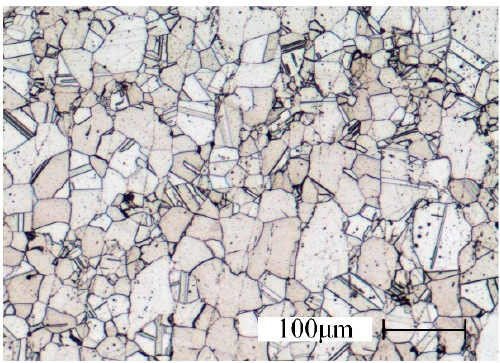
Figure 4. Microstructure of FGH96.